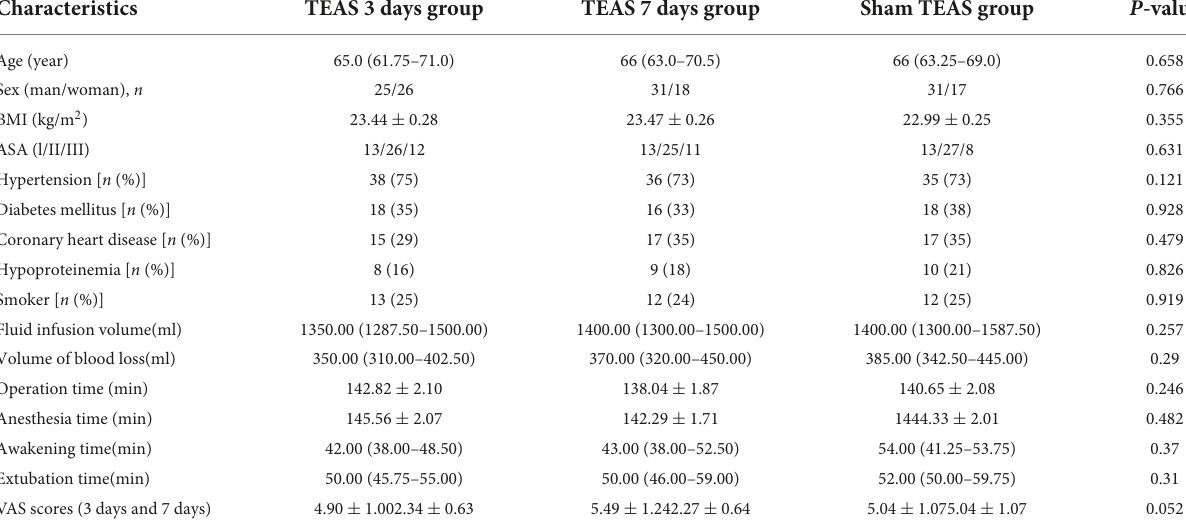
TABLE 1 General information of three groups of patients and intraoperative and postoperative